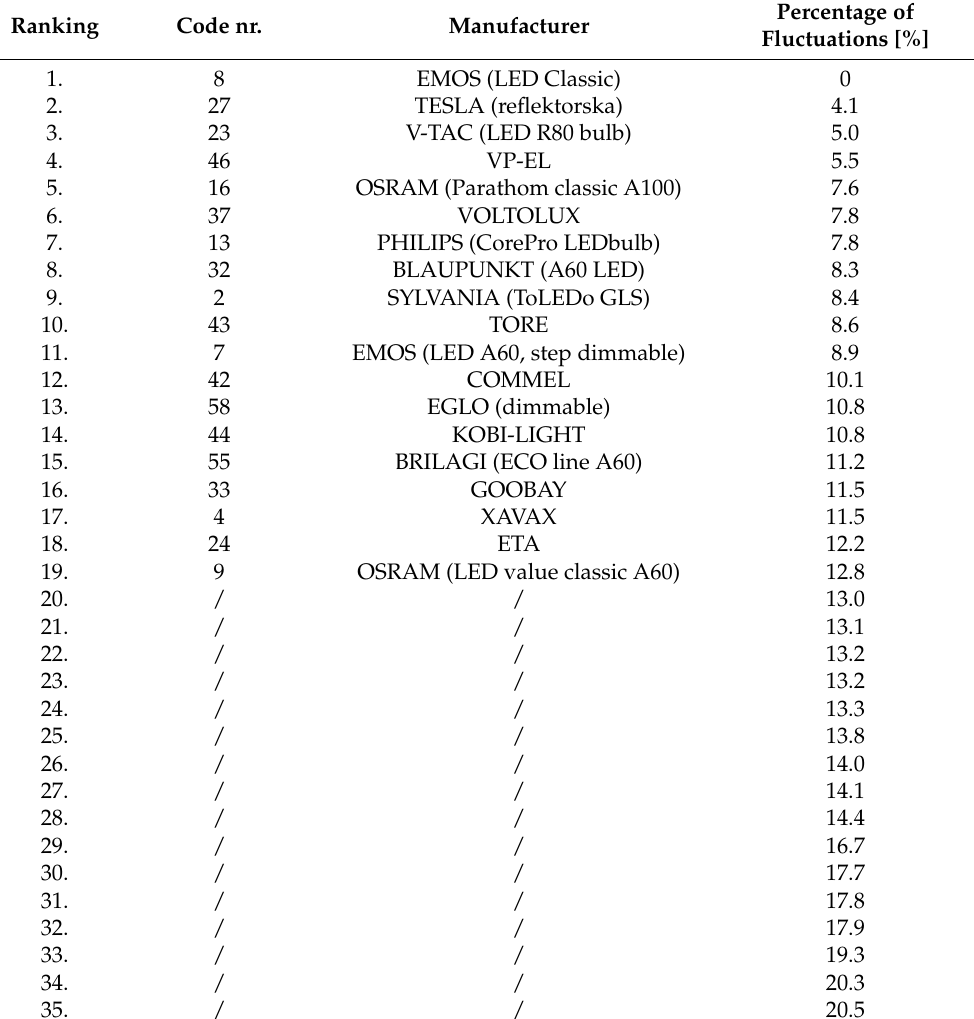
Table 2. Classification of LED light bulbs based on the percentage of fluctuations in the luminous